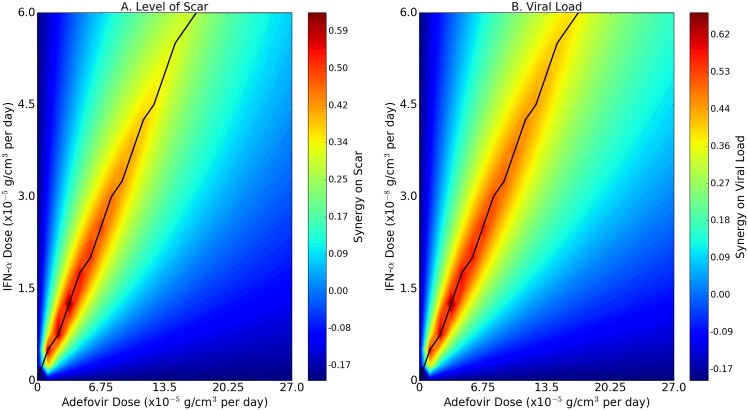
Synergy map for drugs IFN-α and adefovir in HBV.The horizontal axes scale the dose of IFN-α and the vertical axes scale the dose of adefovir. The color maps represent the synergies between the two drugs IFN-α and adefovir in reducing the level of scar density (A) and the viral load (B) at day 180 of infection.